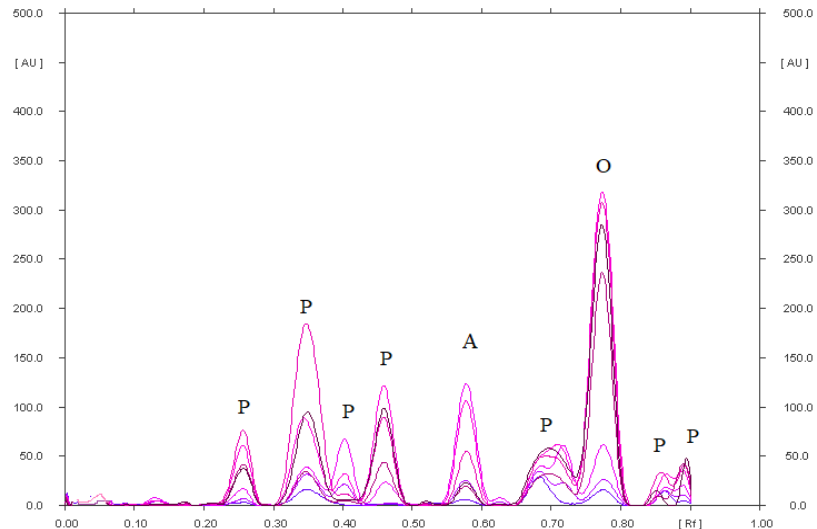
Figure 3. Densitogram of omeprazole (4 µg) in an acidic solution, which after heating was separated on silica gel using a mobile phase chloroform – methanol – ammonia (36:4:0.60, v / v / v ); where: O-omeprazole, A-omeprazole related compound A and P-unidentified omeprazole degradation products.